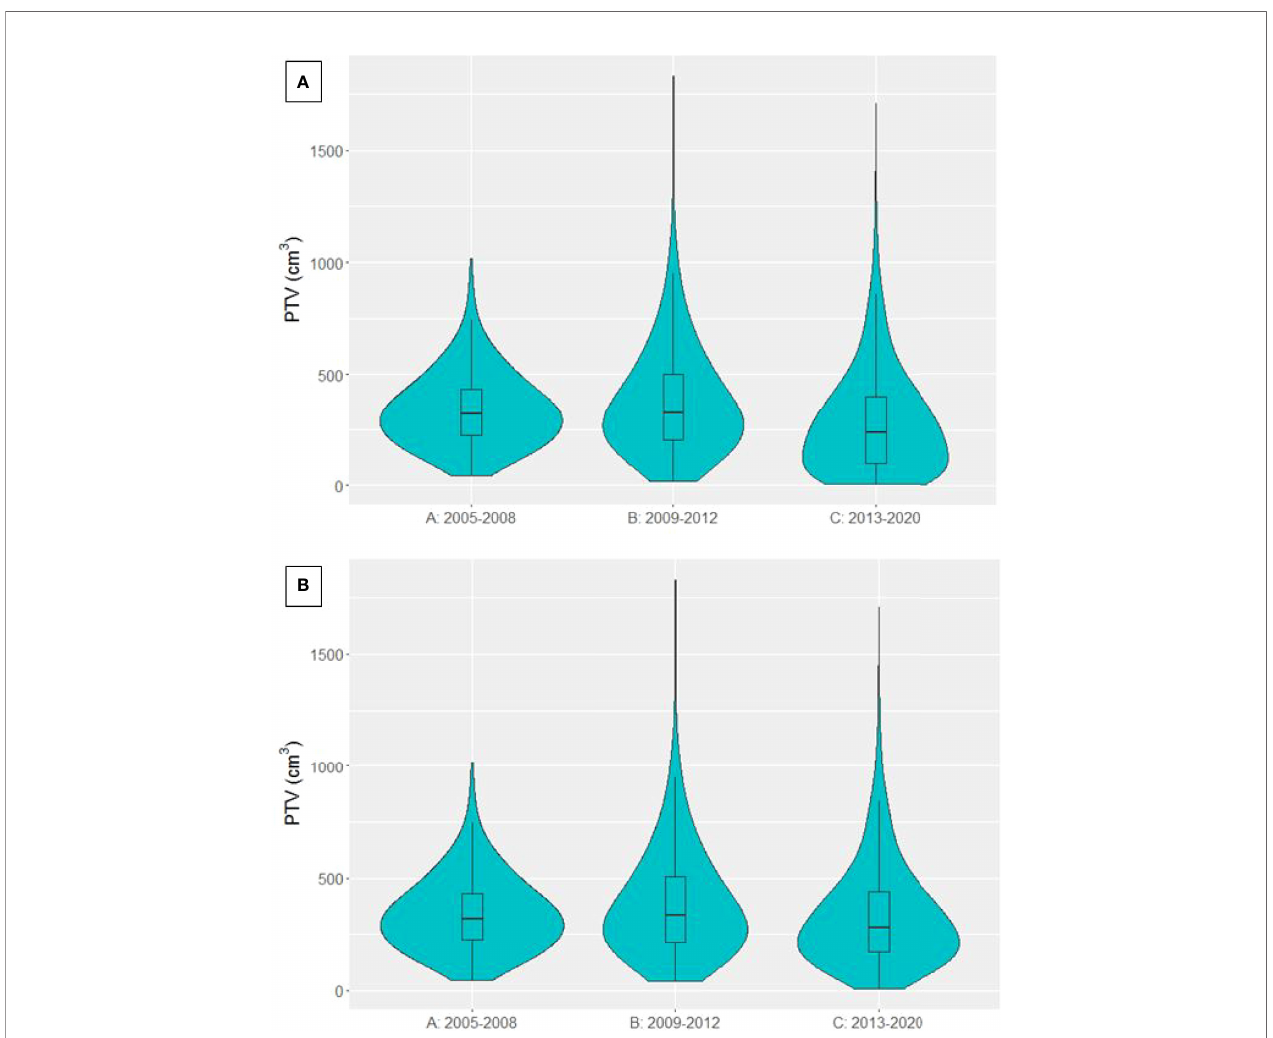
FIGURE 5 | Violin plot presenting the distribution of PTVs from patients treated with curative-intent radiotherapy in each time period. (A) SABR patients included (B) SABR patients